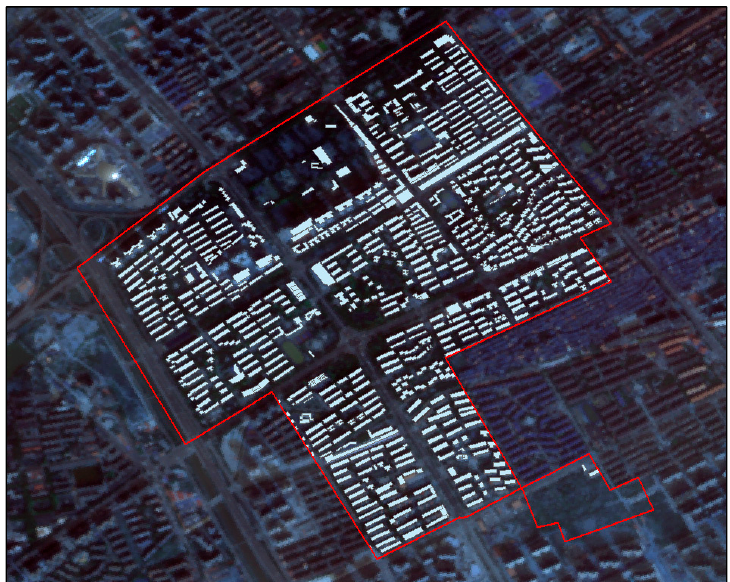
the upper and middle left part and the lower right part are clearly missing. The area of this subdistrict is less than 2.5 km 2 , and the number of missing buildings is high, thereby greatly impacting the accuracy of the model.